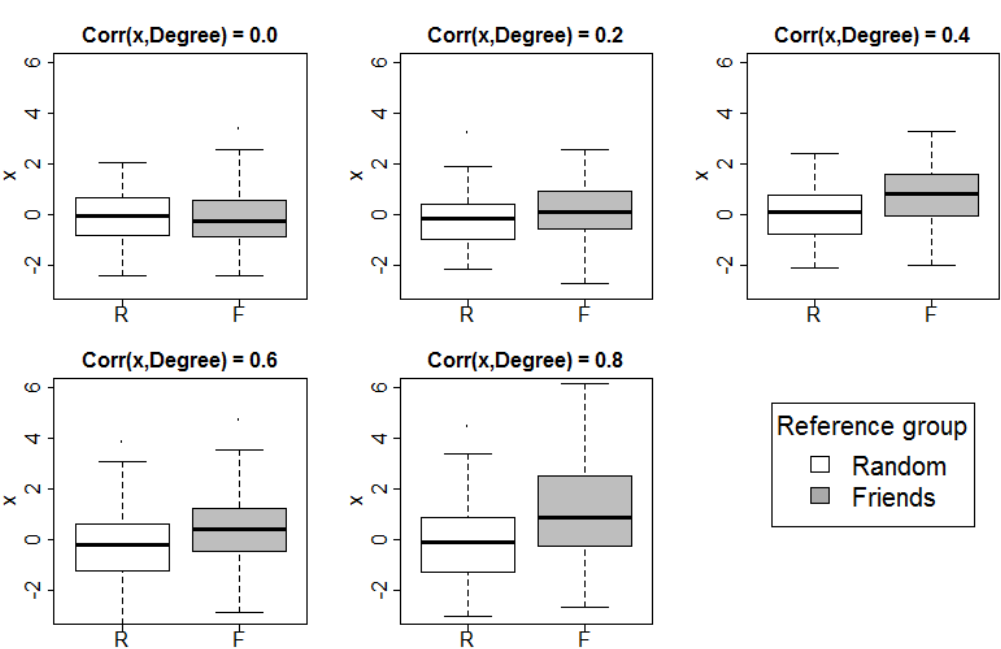
Figure 6: Convergence points with different correlations between attribute and degree